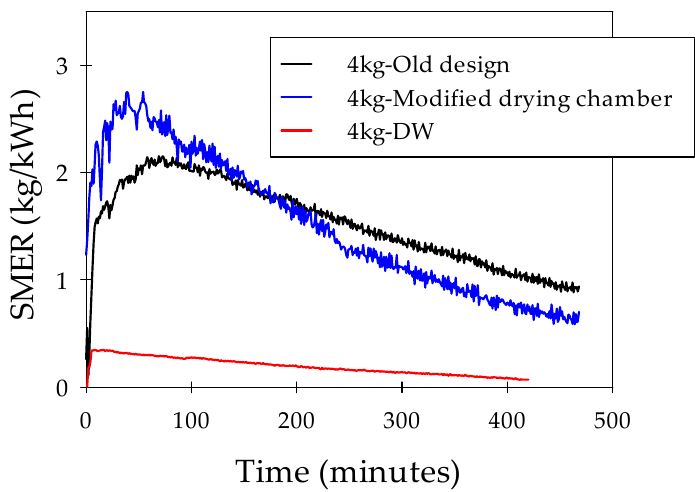
Figure 15. Specific moisture extraction rate versus drying time.